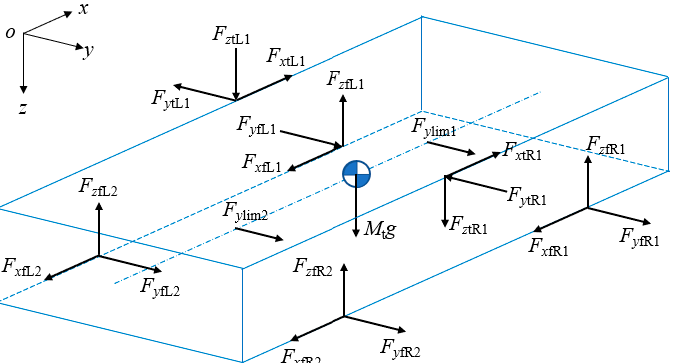
Figure 4. Force analysis of car bogie frame.